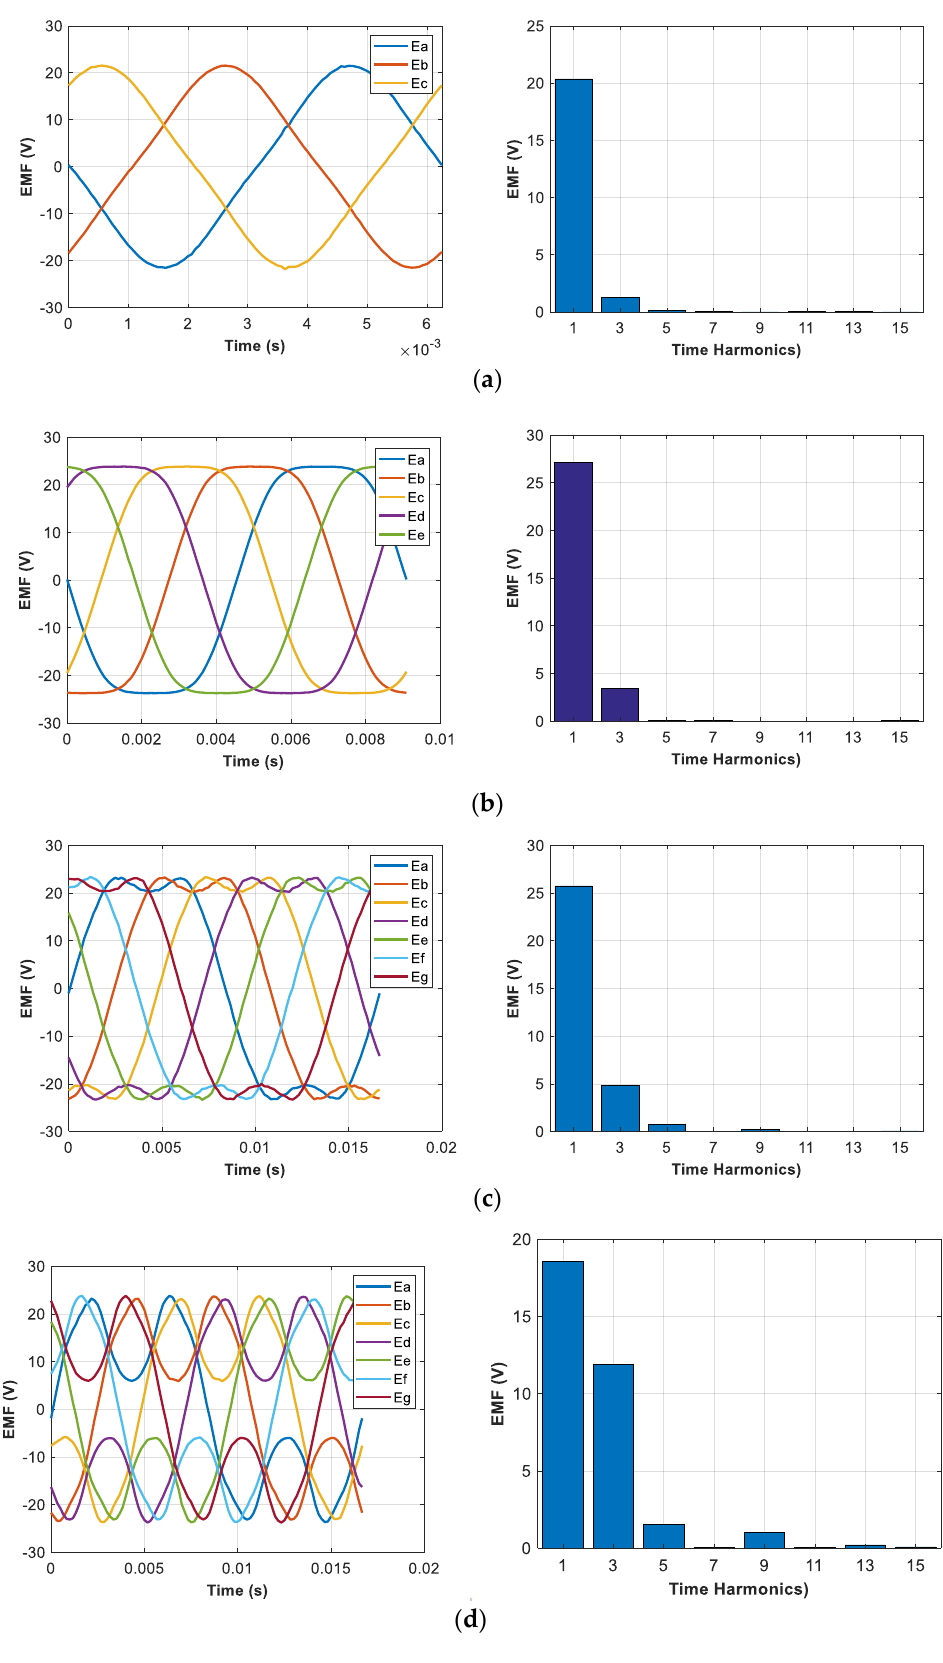
Figure 7. EMFs and spectrum harmonics of ( a ) three − phase IPM; ( b ) five − phase SPM; ( c ) seven − phase AFM; ( d ) seven − phase HFM.